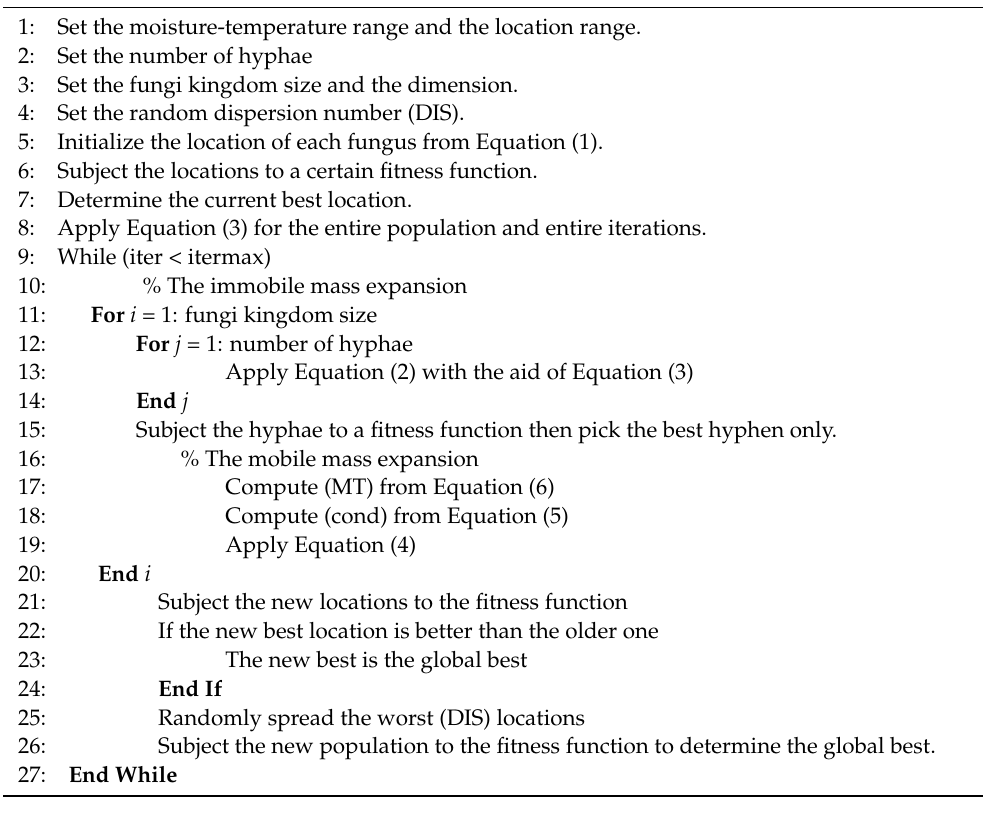
Algorithm 1 Fungi kingdom